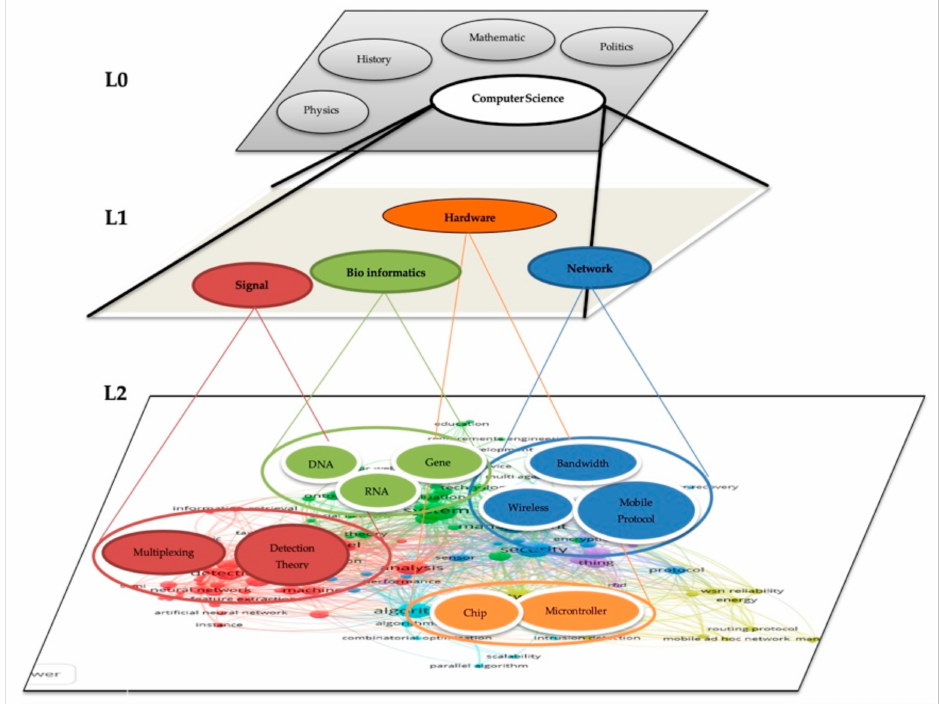
Figure 5. The topics’ hierarchy layers